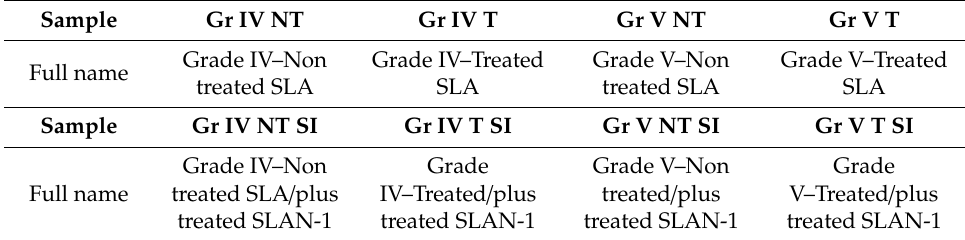
Figure 1. On the left are samples without a TiO 2 film and on the right, samples with TiO 2 . Table 1. Nomenclature of the original and modified samples used in the study. (Gr V: Grade V; Gr IV: Grade IV; T: Treated SLA; NT: Non-treated SLA; SI: Treated with plasma generated by an external SLAN-1 microwave